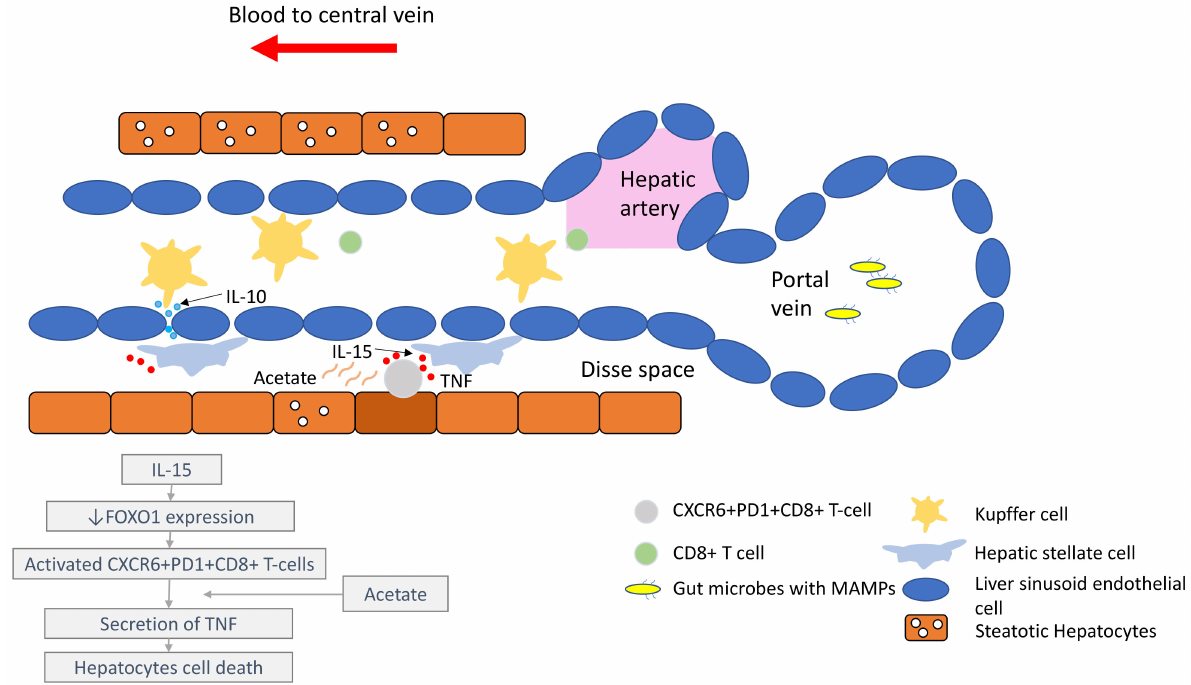
Figure 1. Liver immune microenvironment in NASH patients. In NASH patients, liver immune tolerance is lost and tips towards pro-inflammation. The IL-15 triggers decreased FOXO1 expression and activates the residential CD8+PD1+ T-cells. These residential T-cells, upon encounter with the acetate secreted by steatotic hepatocytes, release TNF, which triggers hepatocyte cell death through a FAS–ligand-dependent manner. This process is thought to bring about the NASH to NASH-HCC